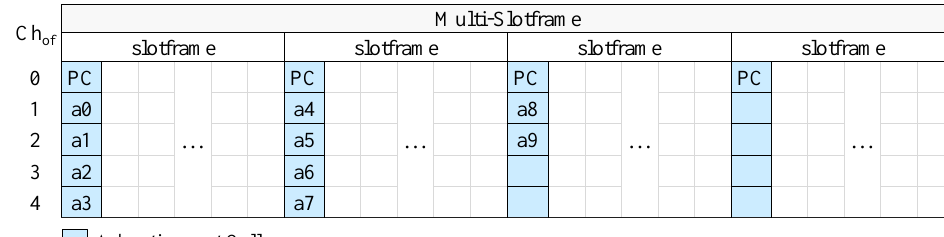
Figure 5. CFAS using horizontal indexing in the case where there are 5 available channels, 11 advertisers (including the PAN coordinator), S = 4 and A s = 1, while the identifiers of the advertisers are consecutive and start from 0.